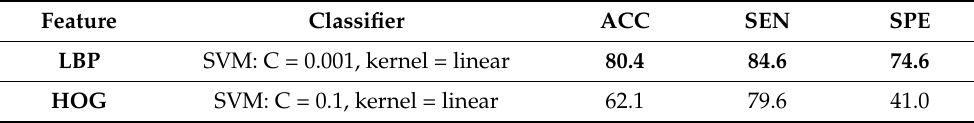
Table 3. PD classification results and optimal parameters in analyzing happiness